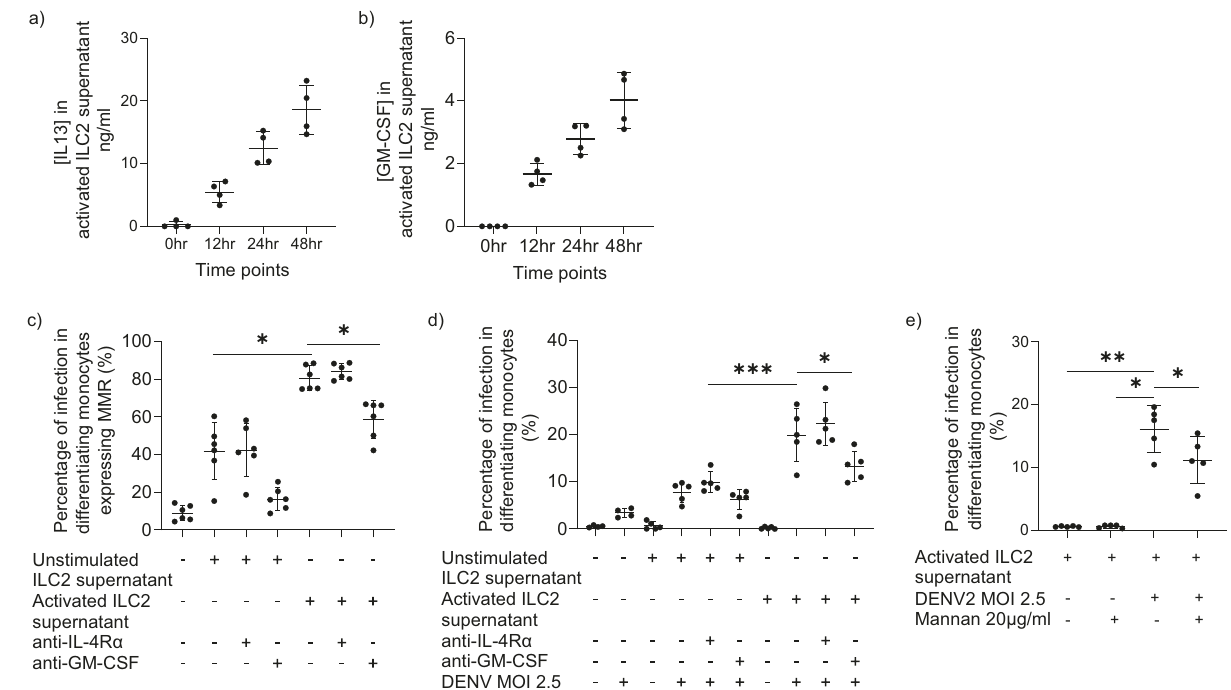
Fig. 5 Activated ILC2 enhance dengue viral infection in monocytes. Ex vivo sorted and expanded ILC2 from healthy individuals were stimulated with IL-33 (50 ng/ml), IL-25 (50 ng/ml), IL-2 (100 IU/ml) for 48 h and a IL-13 and b GM-CSF ELISA assays were performed on the supernatants of ILC2 at 0, 12, 24, 48 hr time points ( n = 4). To demonstrate the effect of ILC2 supernatant on monocytes, unstimulated ILC2 were incubated with IL-2 (100 IU/ml) and activated ILC2 were incubated with IL-33 (50 ng/ml), IL-25 (50 ng/ml), IL-2 (100 IU/ml) for 48 h and the supernatants were collected. Unstimulated and activated ILC2 supernatants were added to CD14 MACS separated monocytes and c MMR expression was measured after 48 h by fl ow cytometry. In the blocking conditions, anti-GM-CSF and anti-IL-4R α were added for 1 h before adding supernatants of ILC2. Statistical signi fi cance was tested using one-way ANOVA with Tukey ’ s multiple comparison test, data representative of three independent experiments ( n = 6). P * < 0.05. d Unstimulated and activated ILC2 supernatants were added on monocytes and cells were infected with DENV2 at an MOI of 2.5 and intracellular dengue E protein was stained after 48 h by fl ow cytometry. Statistical signi fi cance was tested using one-way ANOVA with Tukey ’ s multiple comparison test, data representative of